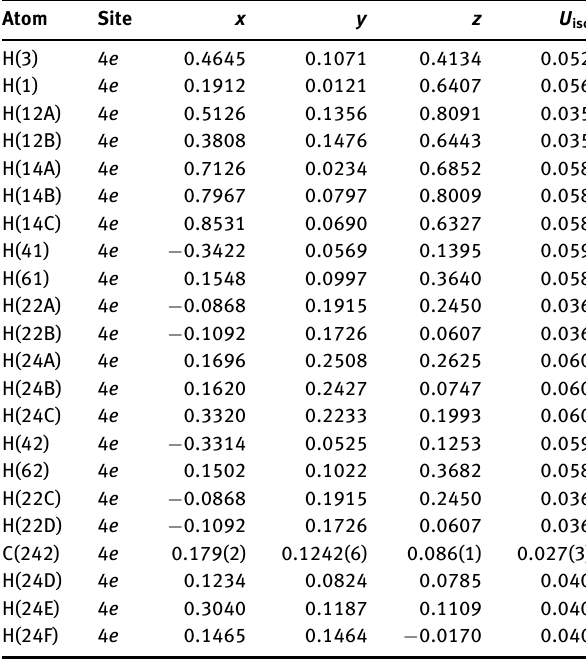
Table 2: Fractional atomic coordinates and isotropic or